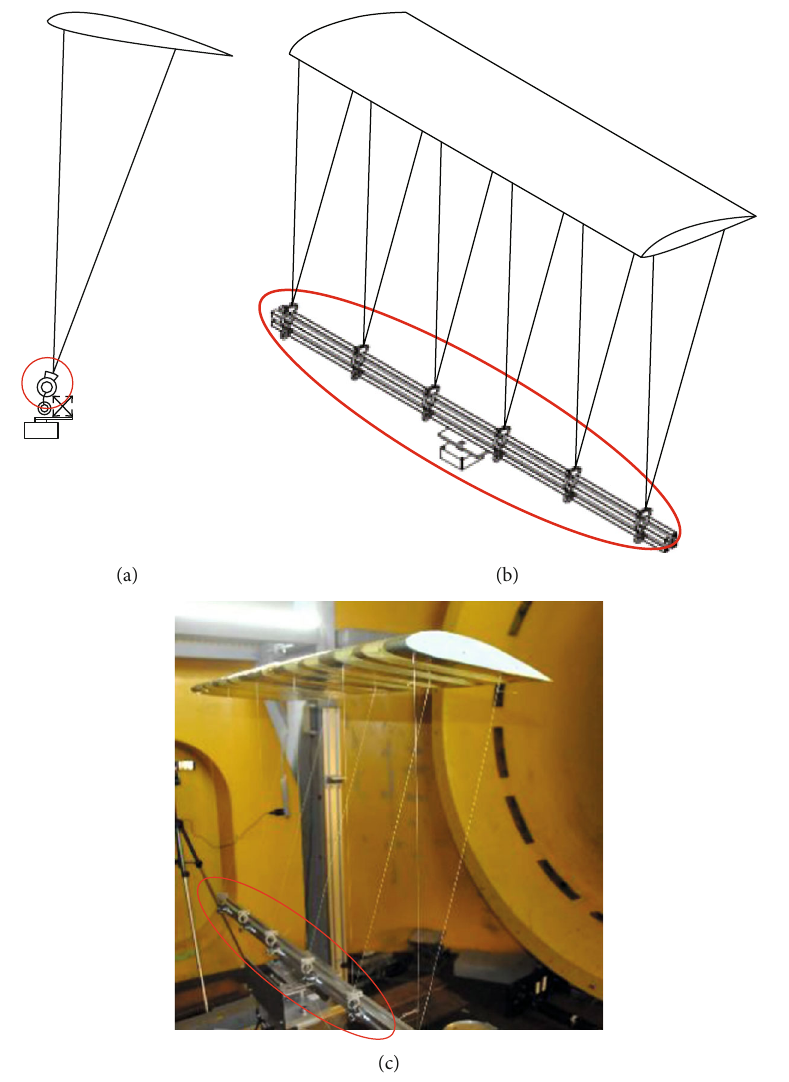
Figure 10: Pattern diagram and picture of the test model. (a) Side view. (b) Isometric view. (c) Actual picture of the test model.